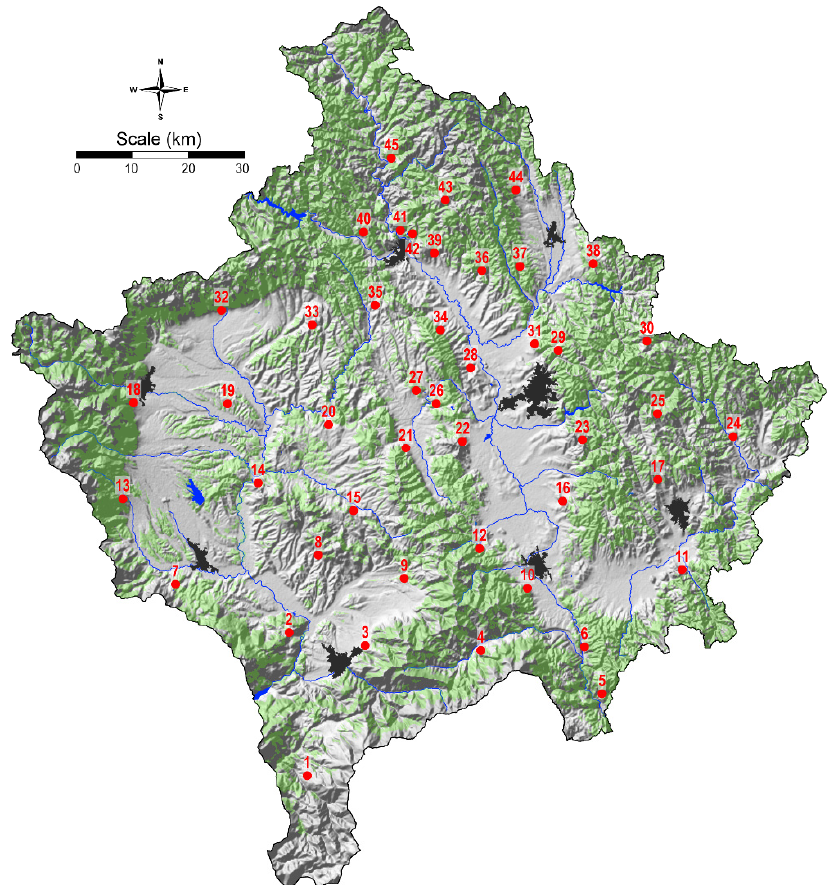
Figure 2. The map of distribution of mosses sampling points in Kosovo.